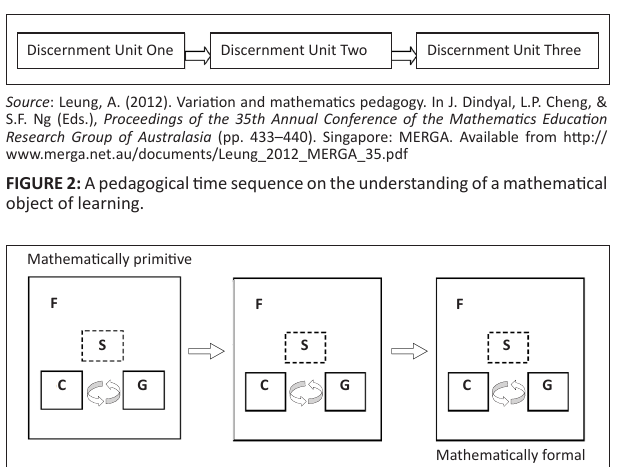
FIGURE 1: A discernment unit driven by types of variation interaction.